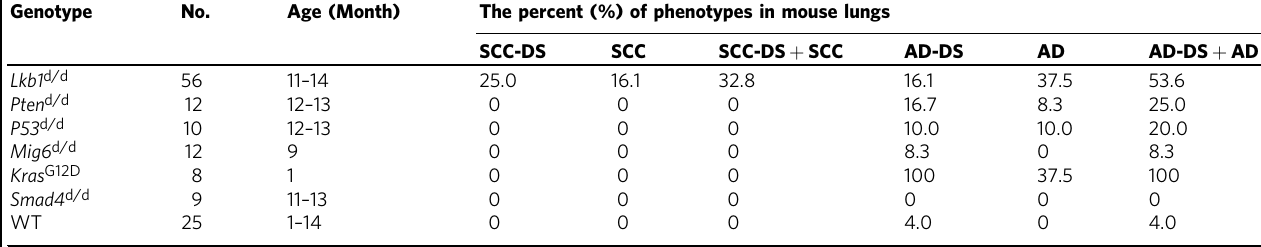
Table 1 Summary of mouse phenotypes of lung tumors and lungs Genotype